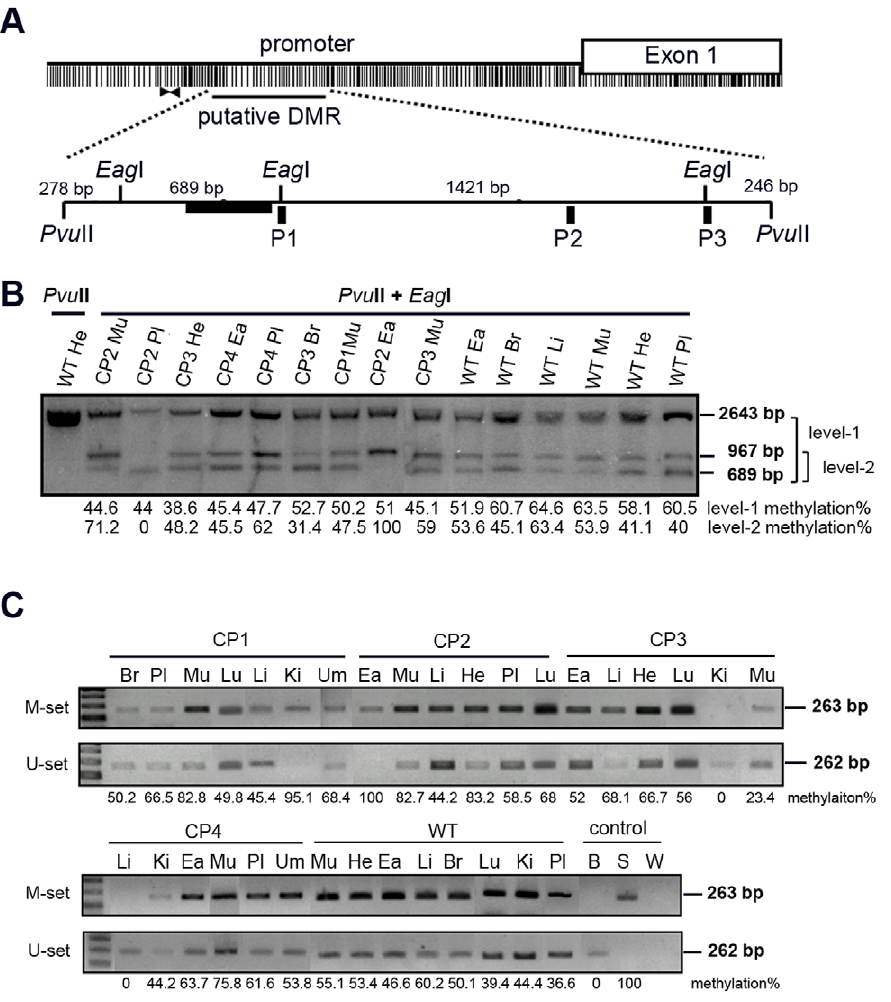
Figure 2. Methylation status of the H19 putative DMR in cloned and wild-type pigs. (A) Schematic of the putative DMR of H19 , located in the promoter. The Southern blot hybridization probe is shown as a black box. P1, P2 and P3 indicate three CTCF-binding sites of the putative DMR. (B) Southern blot hybridization results in the H19 DMR in cloned pigs. The level-1 methylation percentage was calculated by the bands of 2643 bp, 967 bp, and 689 bp. The level-2 methylation percentage was calculated by the bands of 967 bp and 689 bp. (C) Methylation-specific PCR analysis of the H19 promoter region in cloned pigs. The black arrow shown in Figure 2A indicates the primer sets used in the MS-PCR assay. The number below the panel indicates the methylation percentage. Br: brain; Ea: ear; He: heart; Ki: kidney; Li: liver; Lu: lung; Mu: muscle; Pl: placenta; Um: umbilical cord; B: blood; S: blood treated with Sss I; W: ddH 2 O.